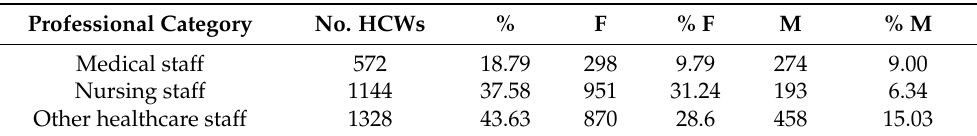
Table 1. Distribution of AOU-SS healthcare workers (HCWs) by professional category and gender (F = females; M = males).